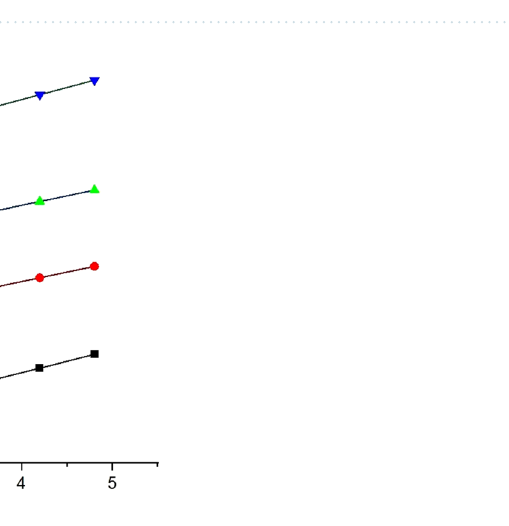
Figure 14. Stress distribution on the chemical gas sensor: ( a ) SnO 2 , ( b ) SnO 2 –Pd, ( c ) SnO 2 –rGO and ( d ) SnO 2 – Pd/rGO.